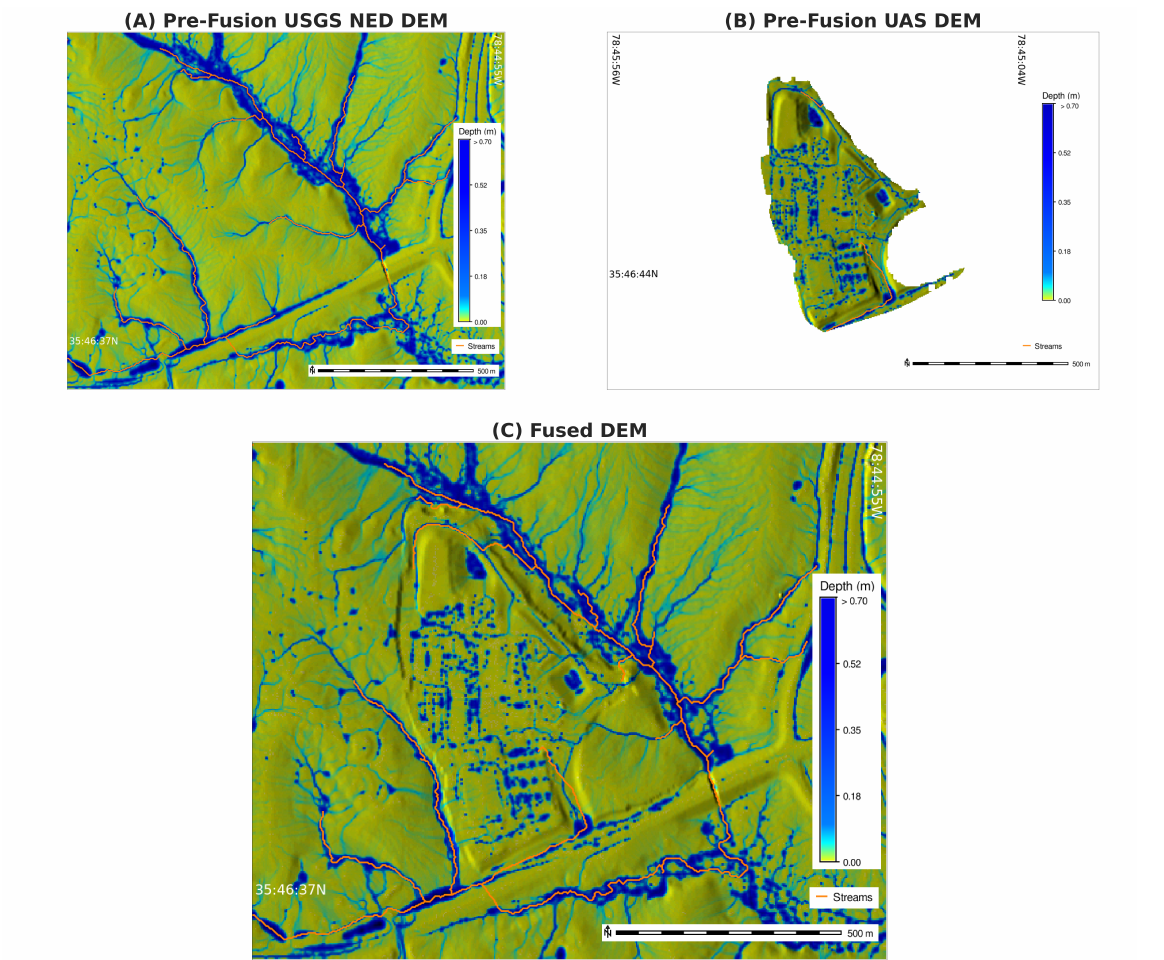
Figure 15. Spatial patterns of surface water flow depths computed using the USGS NED DEM ( A ), UAS DEM ( B ) and the fused DEM ( C ). The fusion ensured smooth flow between the USGS NED DEM and the area mapped by UAS.